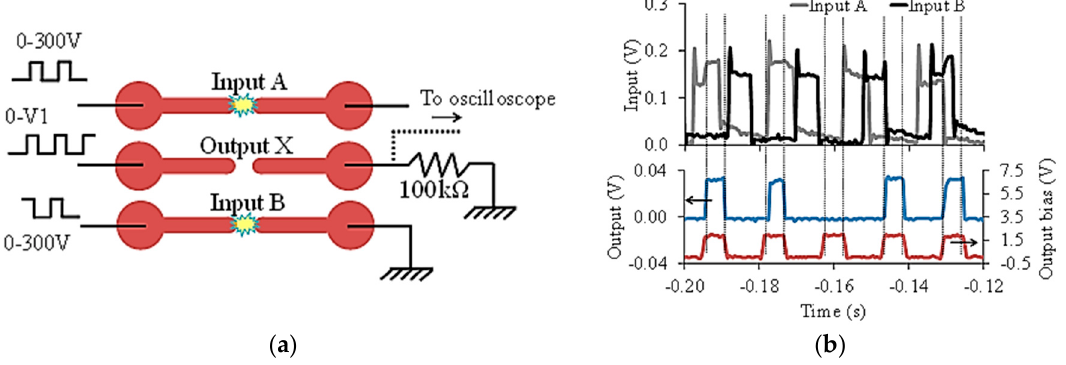
Figure 15. The electrode configuration used to implement OR logic is shown in ( a ) and is similar to the experiment shown in Figure 14c. The response of the OR gate is shown in ( b ). The output is valid only when output bias is high. The amplitude of output bias pulse is 195 V in this case. Both the figures are reproduced from [35].